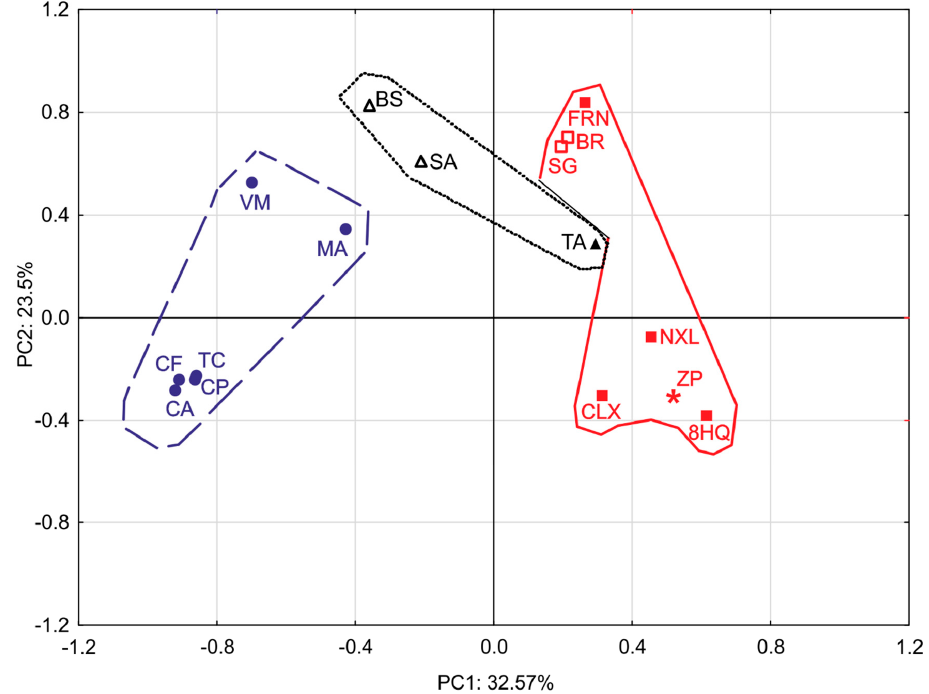
Figure 2. Principal component analysis of antibacterial and cytotoxic activities of phytochemicals, their synthetic analogues, and antibiotics against intestinal bacteria and cells in vitro . BR: berberine,